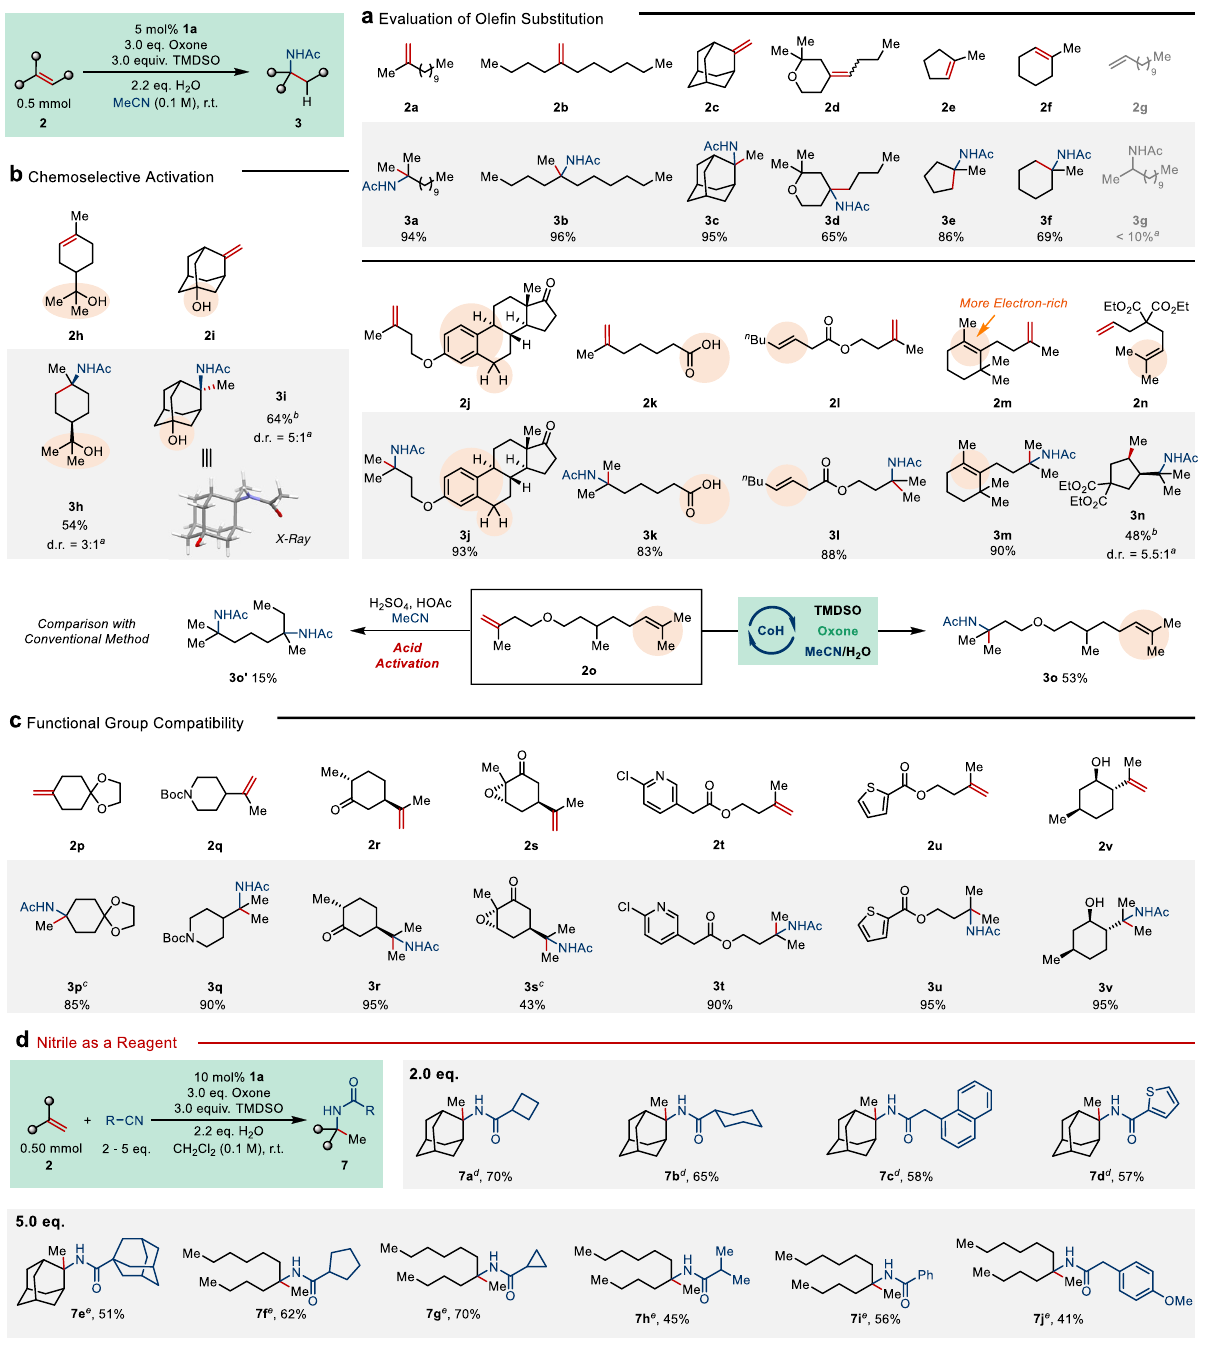
Fig. 3 Scope of the Co-catalyzed hydroamidation. a Evaluation of ole fi n substitution. b Demonstration of chemoselective activation. c Evaluation of Functional group compatibility. d Using reagent quantities of nitrile. Unless noted otherwise, yields correspond to isolated, analytically pure material. Conditions: 2 (0.50 mmol), 1a (5 mol%), oxone (3.0 equiv.), TMDSO (3.0 equiv.), H 2 O (2.2 equiv.) in 5.0 mL MeCN at r.t. for 18 h. a Determined by 1 H NMR analysis of the crude reaction mixture. b Isolated yield of the major diastereomer. c With additional 2,6-lutidine (2.0 equiv). d 2 (0.50 mmol),